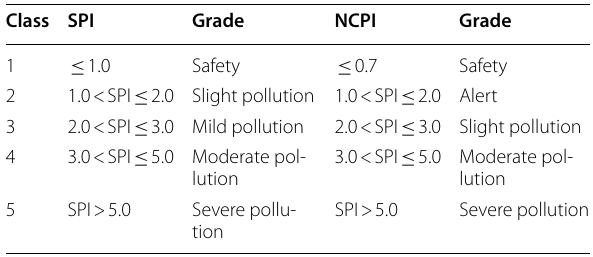
Table 1 Classes of the single pollution index (SPI) and